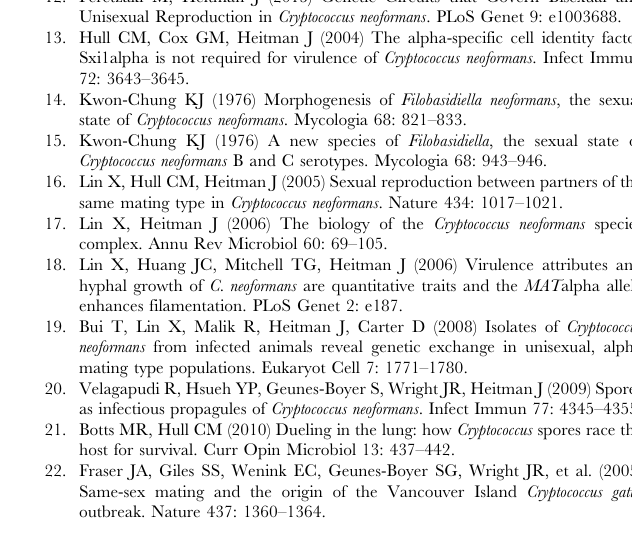
Figure S2 PUM1 is a downstream target of Znf2. (A) A schematic diagram of predicted domains of Pum1. Pum1 is a member of the Pumilio regulator family. It contains the PUM-HD (Pumilio-Homology Domain), which is generally involved in gene regulation via binding to RNAs. (B) The PUM1 expression level was positively regulated by Znf2 based on the transcriptional analysis by qPCR. The expression level of the PUM1 gene in the wildtype strain XL280 was arbitrarily set as 1 for comparison. Figure S3 Cfl1 and Pum1 are not engaged in invasive growth under different conditions. (A) The deletion of PUM1 or CFL1 drastically reduced the abundance of aerial hyphae (white fluffy appearance of the colony) but not invasive growth during bisexual mating on V8 agar medium. In comparison, the deletion of ZNF2 abolished hyphal growth and invasive growth. (B) The indicated strain pairs were mixed and incubated on YPD agar medium (mating-suppressive) for 5 days before being photographed. The deletion of ZNF2 , but not PUM1 or CFL1 abolished invasive growth. Scale bar: 2 mm. Figure S4 Pum1 but not Cfl1 is involved in promoting hyphal extension during unisexual reproduction. The strains with same cell concentration were spotted onto V8 agar and incubated for 5 days. Hyphal length was positively related to the PUM1 expression level (disrupted or overexpressed). Cfl1 did not have any major impact on hyphal extension during unisexual mating. Scale bars: 30 m m. Figure S5 The overexpression of ZNF2 cannot bypass the requirement for PUM1 in promoting sustained hyphal growth. The aerial hyphae were extremely sparse in the pum1 D / cfl1 D mutant even in response to ZNF2 overexpression, which prohibited further analysis of aerial hyphal length in this strain. By contrast, invasive hyphae were only modestly affected when ZNF2 was overexpressed in this double deletion mutant. The